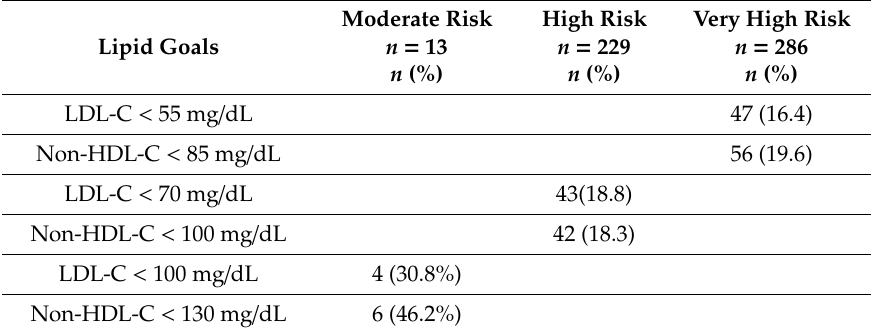
Table 3. Proportion of patients that achieved the lipid goals recommended by the 2019 European Guidelines on Diabetes according to the risk categories.